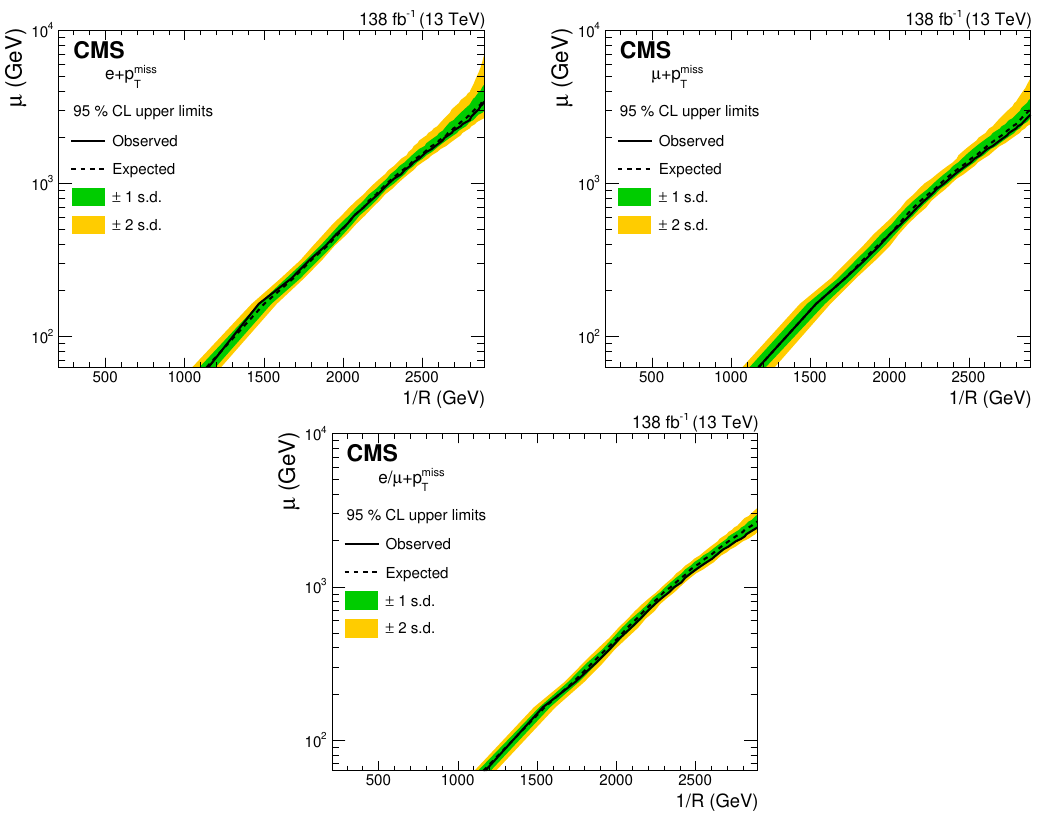
Figure 8 . Exclusion limits in the 2D plane ( 1 /R, µ ) for the split-UED interpretation for the n = 2 case. These are shown for the electron (upper left), muon (upper right), and the combination of both (lower) channels for the 2016–2018 data sets. The expected limit is depicted as a black dashed line. The one and two standard deviation uncertainty bands for the expected limits are shown. The experimentally excluded region is the entire area to the left of the solid black